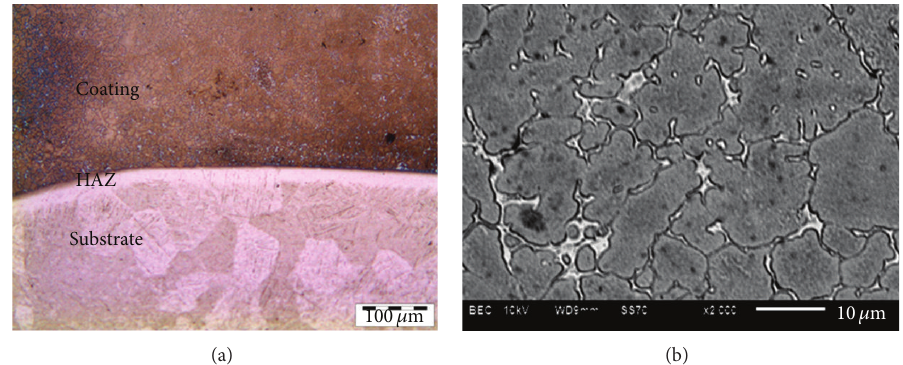
Figure 2: Micrographs of the laser deposited Ti50Ni50 coating; (a) optical image showing the interface of the coating and substrate; (b) SEM image of the coating.